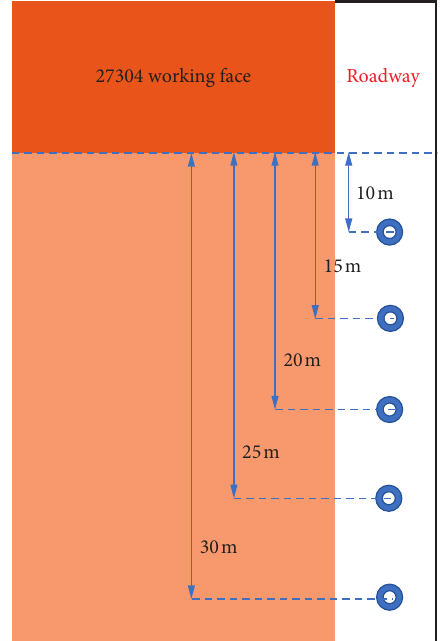
Figure 10: Schematic diagram of measuring point position.